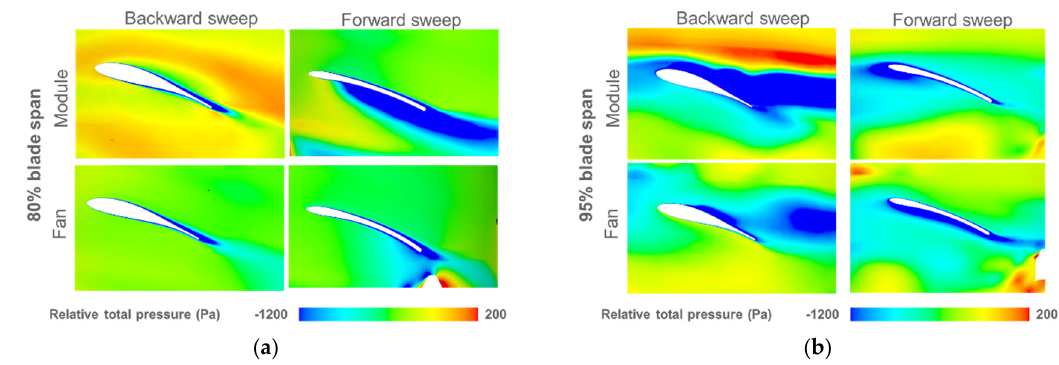
Figure 14. Relative total pressure distributions at constant span: ( a ) at 80% blade span, and ( b ) at 95% blade span.